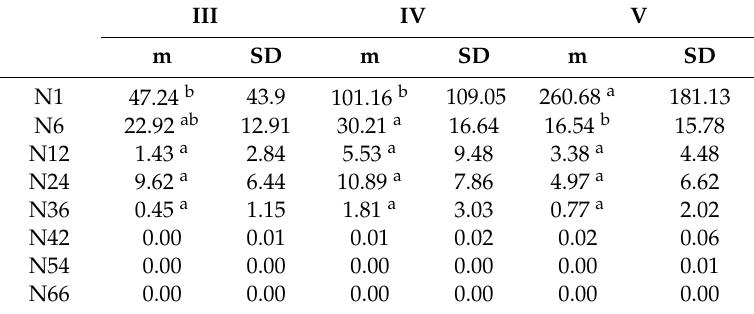
m—mean; SD—standard deviation; N1, N2 ... —water absorbability in a time interval (1 h, 6 h. 12 h, 24 h, 36 h, 42 h, 54 h and 66 h); di ff erent uppercase alphabets in the upper index mean significant di ff erences between deadwood species. Table 5. Comparison of water absorbability for each degree of deadwood decomposition after subsequent hours of immersion in